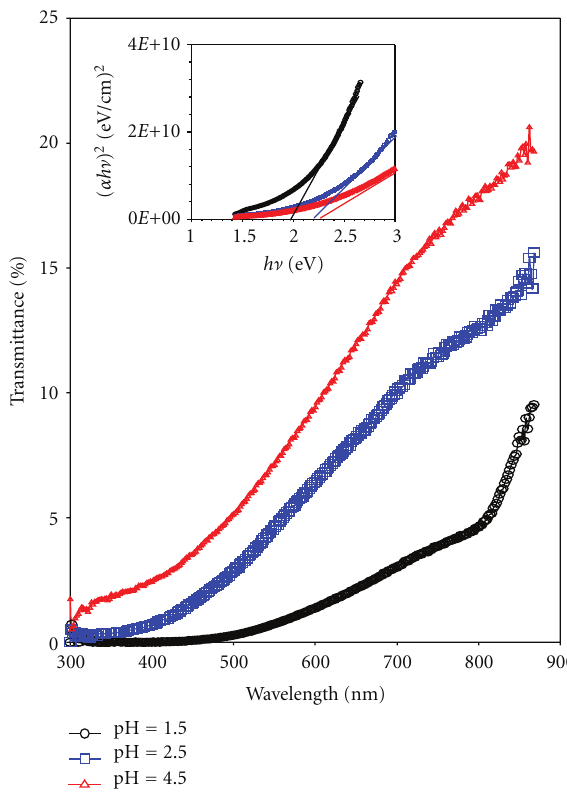
Figure 4: UV-visible of CuInS 2 films electrochemical deposited at − 1.0V from solution containing 5mL of 0.1 M copper chloride, 5mL of 0.1 M InCl 3 , and 150 mL of 0.1 M Na 2 S 2 O 3 at di ff erent pHs inset: band gap estimation.